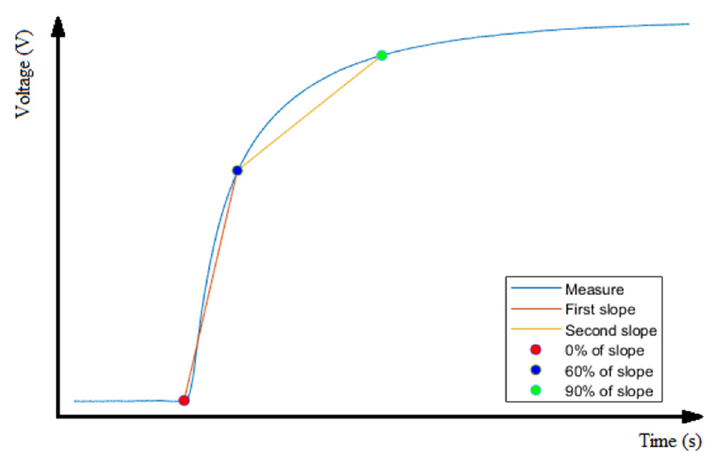
Figure 11. How slopes are measured.